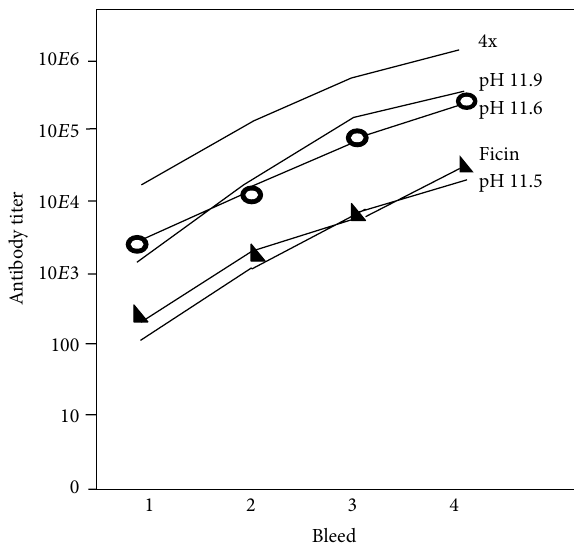
Figure 11: Average anti-GFP IgG ELISA titers after subcutaneous YCP-U65-GFP vaccination. Grey triangles: mice vaccinated with YCPs from ficin-treated cells. YCPs from cells processed at pH 11.5 gave very similar data. Open circles: mice vaccinated with YCPs from cells processed at pH 11.6. Mice vaccinated with YCPs from cellsprocessedatpH11.9gaveverysimilardata. Theupperline, mice vaccinated with 4x doses of pH 11.9 YCPs.